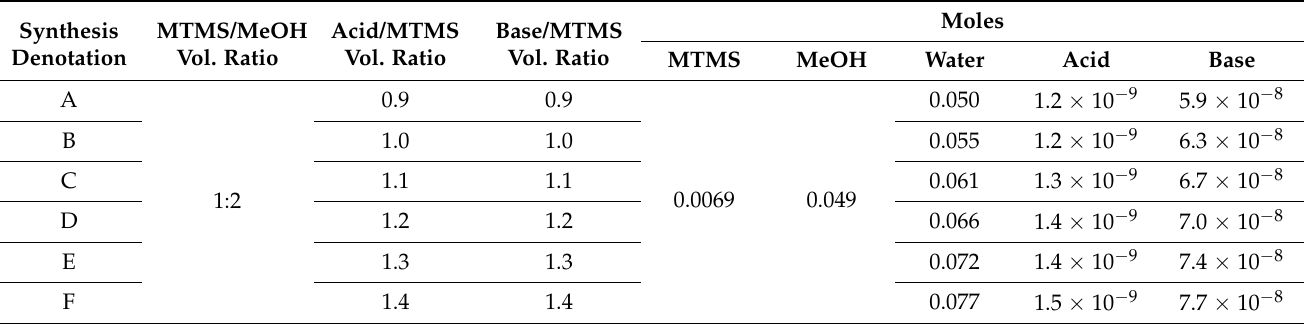
Table 6. Chemical composition of the studied MTMS-based alcogel samples.